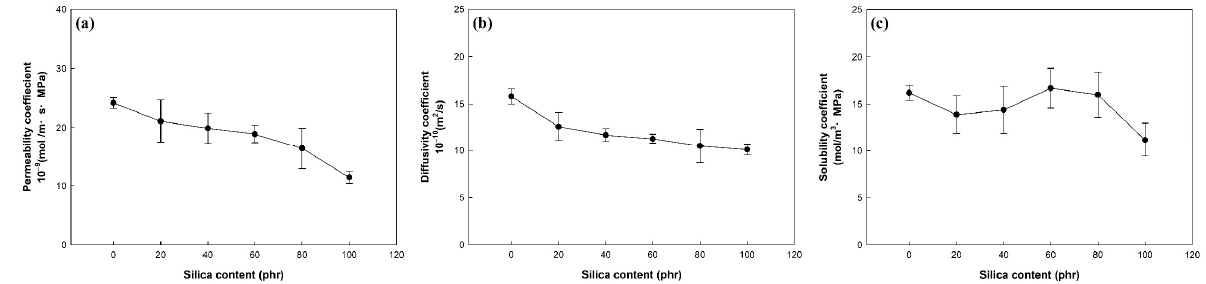
9 of 15 Figure 4. Dynamic mechanical analysis of the EPDM/silica vulcanizates: ( a ) storage modulus, ( b ) tan δ , and ( c ) glass transition temperature . 3.5. Hydrogen Permeation Properties of EPDM/Silica Vulcanizates Figure 5 and Table 4 show the permeability, diffusivity, and solubility coefficient for the hydrogen gas of the EPDM/silica vulcanizates. As shown in Figure 5a, the permeabil- ity coefficient of silica-filled EPDM vulcanizates is lower than that of unfilled EPDM vul-